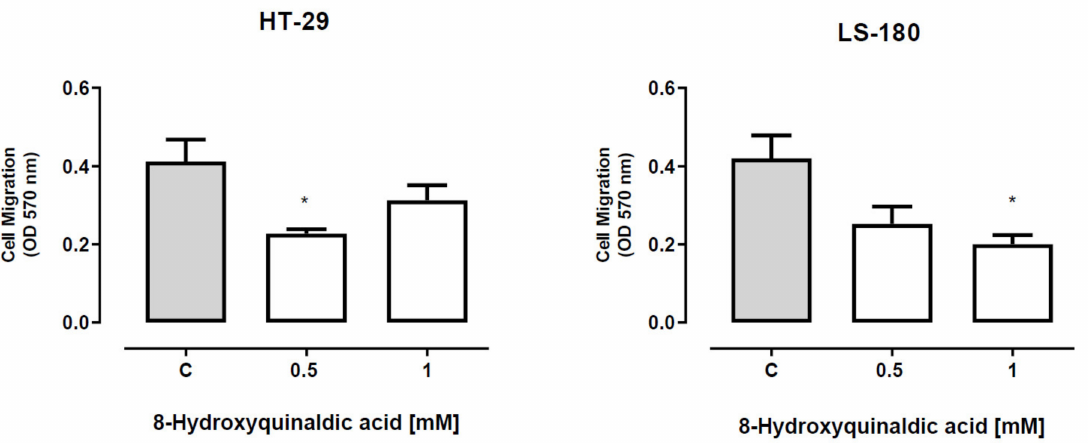
Figure 6. The e ff ect of 8-hydroxyquinaldic acid on migration of human colon adenocarcinoma cells. The migration of HT-29 and LS-180 cells through a monolayer of human umbilical vein endothelial HUVEC cells was assessed byMillipore (cid:48) s QCM tumor cell transendothelial cell migration assay. Data represent the OD value (570 nm) ± SEM of three independent experiments. The absorbance was proportional to the migration of tumor cells.Results were designated as statistically significant in comparison to the control (C) when * p < 0.05 (unpaired Student’s